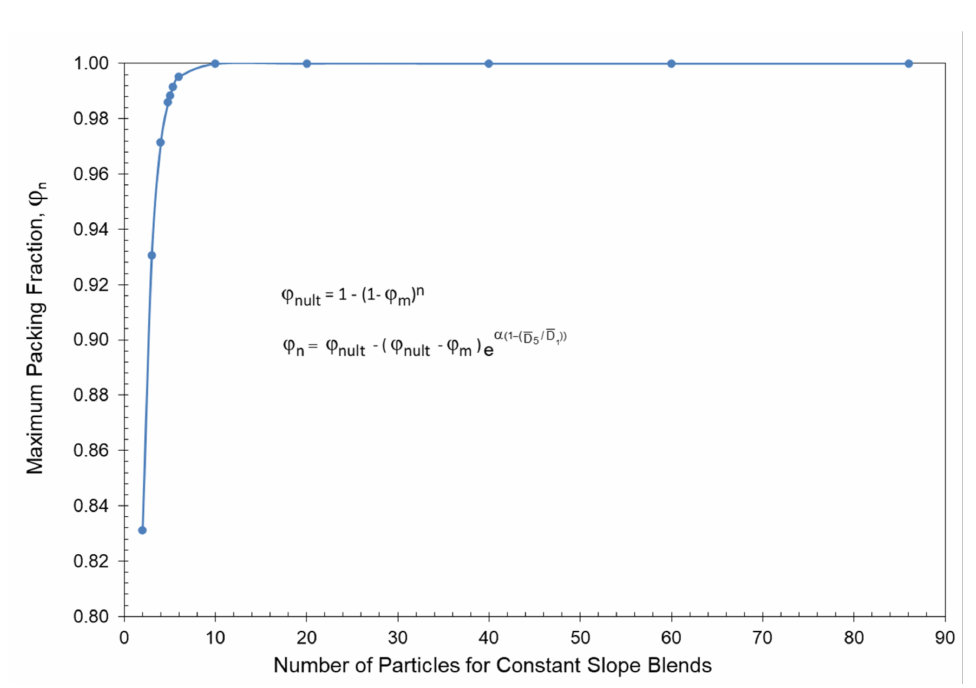
Figure 14. Maximum packing fraction vs. number of different particles in constant slope